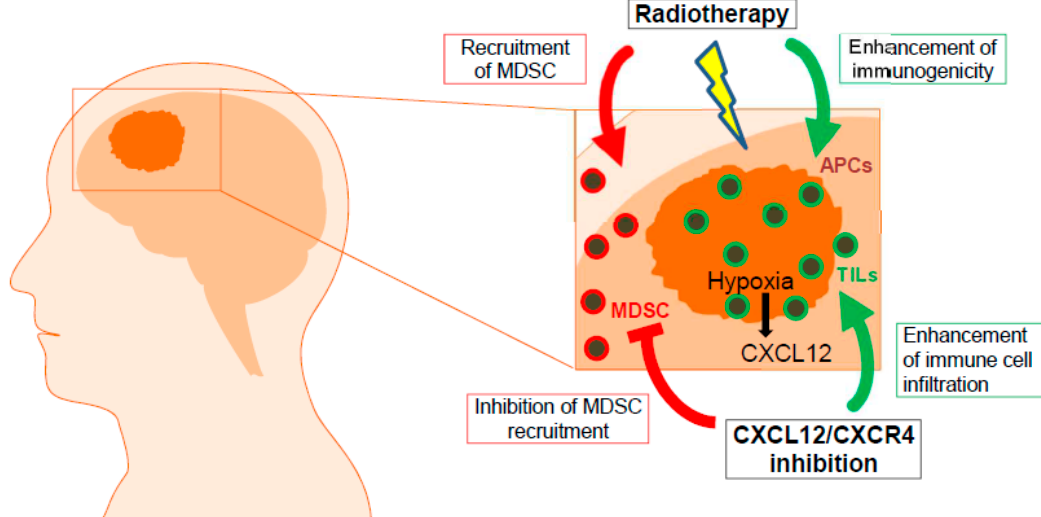
Figure 1. Components of the glioblastoma tumor microenvironment. APC: antigen-presenting cells; MDSC: myeloid-derived suppressor cells; TIL: tumor-infiltrating lymphocytes; CXCL12: C-X-C chemokine ligand 12; CXCR4: C-X-C chemokine receptor 4.